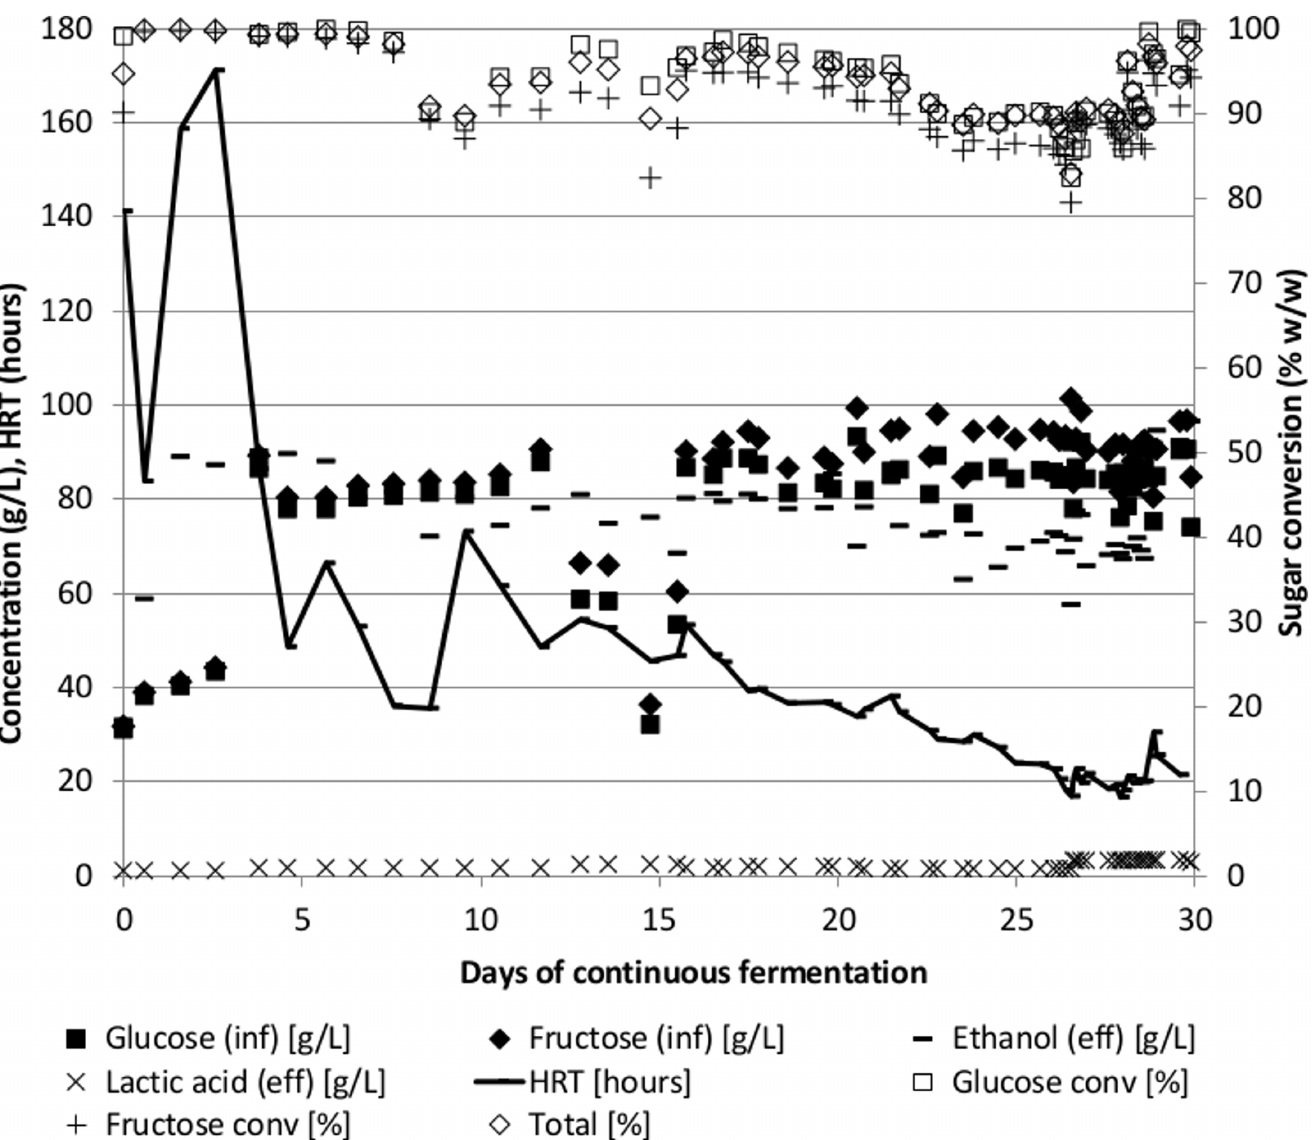
Fig 4. Time course of continuous fermentation of sugar cane syrup using the thermophilic anaerobic bacterium Thermoanaerobacter Pentocrobe 411S. Inf: HPLC data from the influent bottle. Eff: HPLC data from the reactor effluent. Ethanol (eff) is a combination of ethanol in the reactor effluent and ethanol from the gas phase exiting the reactor system. The conversion of sugars in % is based on the concentration in the reactor relative to the concentration in the influent. HRT: Hydraulic retention time.